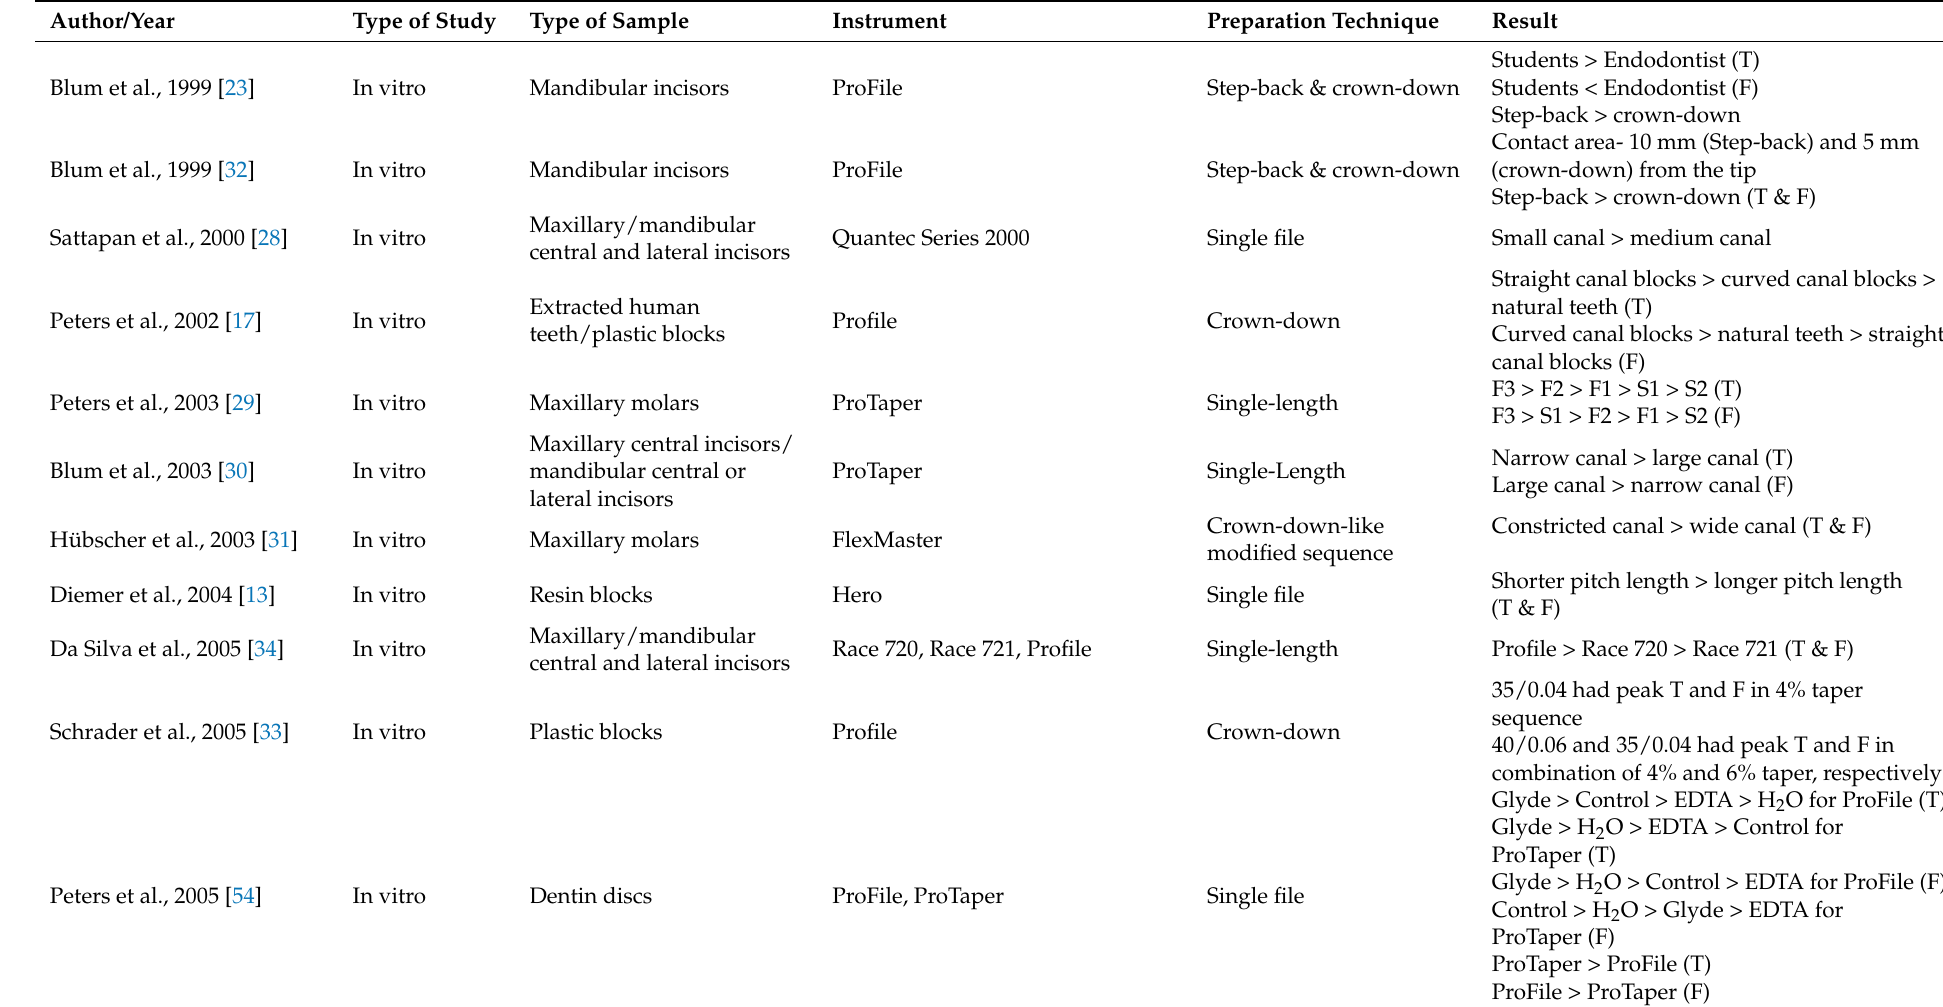
Table 1. Summary of reviewed studies analyzing torque and force generated by nickel-titanium rotary instruments during root canal